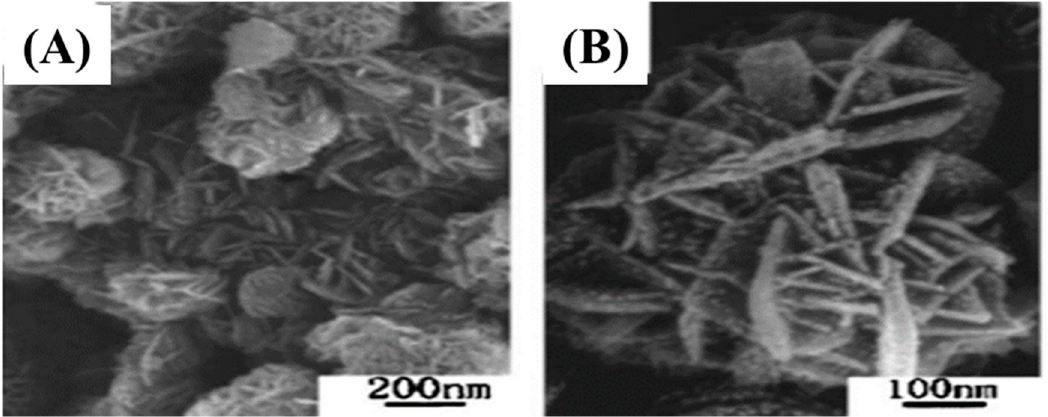
Figure 8. Low ( A ) and high ( B ) magnification FE-SEM images of 2D 2H-SiC nanoflakes [89].